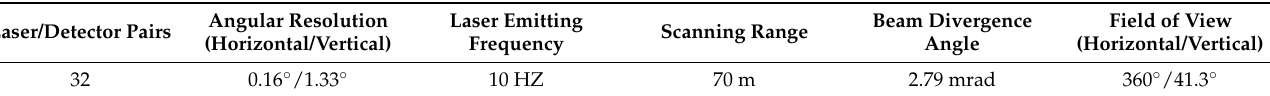
Figure 3. Our simulation program diagram shows the multi-return scanning results caused by the laser characteristics of beam divergence for our studied forest plot. The position of scanner was set at pink point in the figure, where the pink red arrows characterized the emission orientation of laser beams. The red points in the figure represent the sampling points on the edges of leaf surfaces that are scanned by laser beams and trigger the first signal returns. Then, the split beams continue along their paths and collide with the consequent vegetative elements, which produce the second returns, represented by green points. If the second returns occur, caused by the beams being intercepted by any edge point on the leaf surface, it is possible to generate the third return (blue points) when the beams with remnant energy collide with the following vegetative elements again. As seen from the diagram, the first returns are near the scanner and the last returns are further from the scanner. Table 2. The technical specifications of the Velodyne HDL-32E